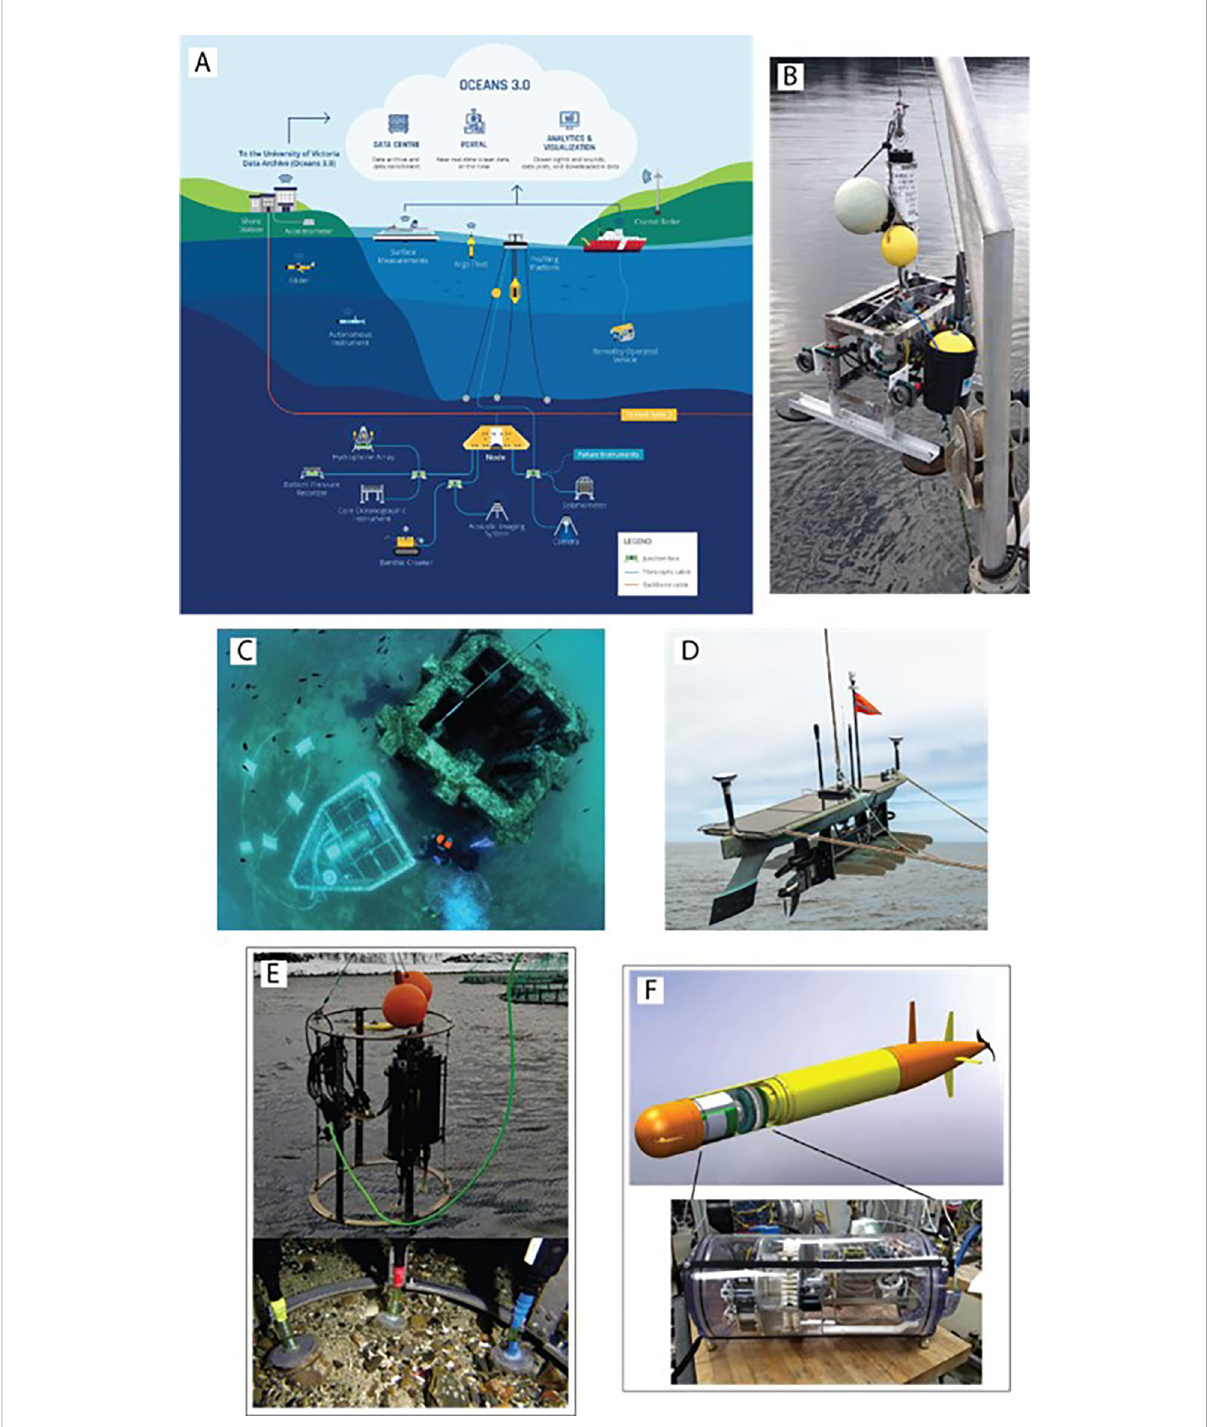
FIGURE 6 Ocean observation opportunities through new technologies. (A) An example of a high-tech platform combining cabled, docked, and autonomous devices as designed by Ocean Networks Canada (ONC); (B, C) Cabled observatories deployed on the sea fl oor in Canada (ONC) and Spain (adapted from Del R ı ́ o et al., 2020; OBSEA) respectively; (D) A GPS-equipped glider for gathering oceanographic and pelagic data deployed by ONC; (E) The substrate-independent benthic sampler, a prototype of a semi-autonomous benthic eDNA sampling device (from Keeley et al., 2021), and (F) the Environmental Sample Processor for autonomous eDNA sampling of the water column (Images by Monterey Bay Aquarium Research